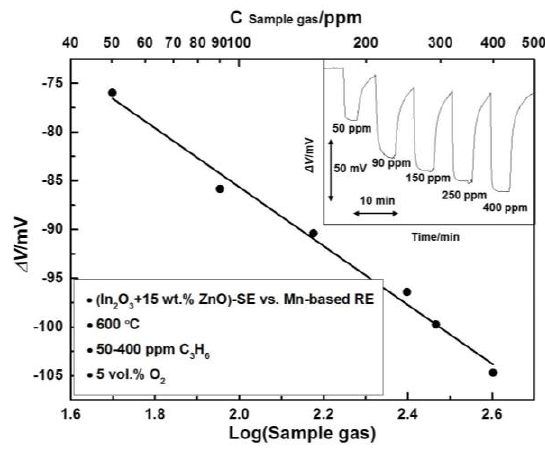
Figure 4. Dependence of the sensing signal ( ΔV ) on the logarithm of C 3 H 6 concentrations; Insert: response transitions to C 3 H 6 in the concentration range of 50–400 ppm.